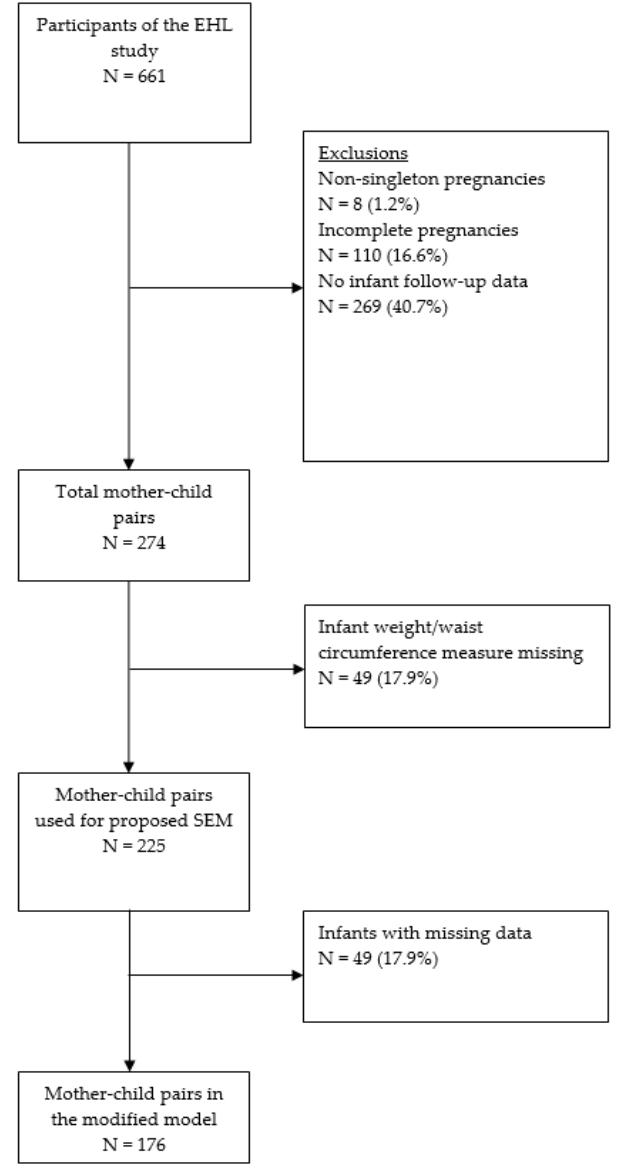
Figure 1. Flow diagram depicting the exclusion of mother–child pairs in the present study .